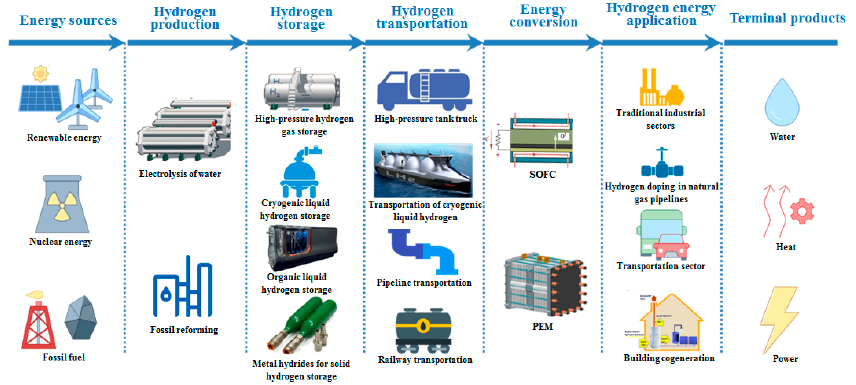
Figure 2. Schematic diagram of the hydrogen industry chain.